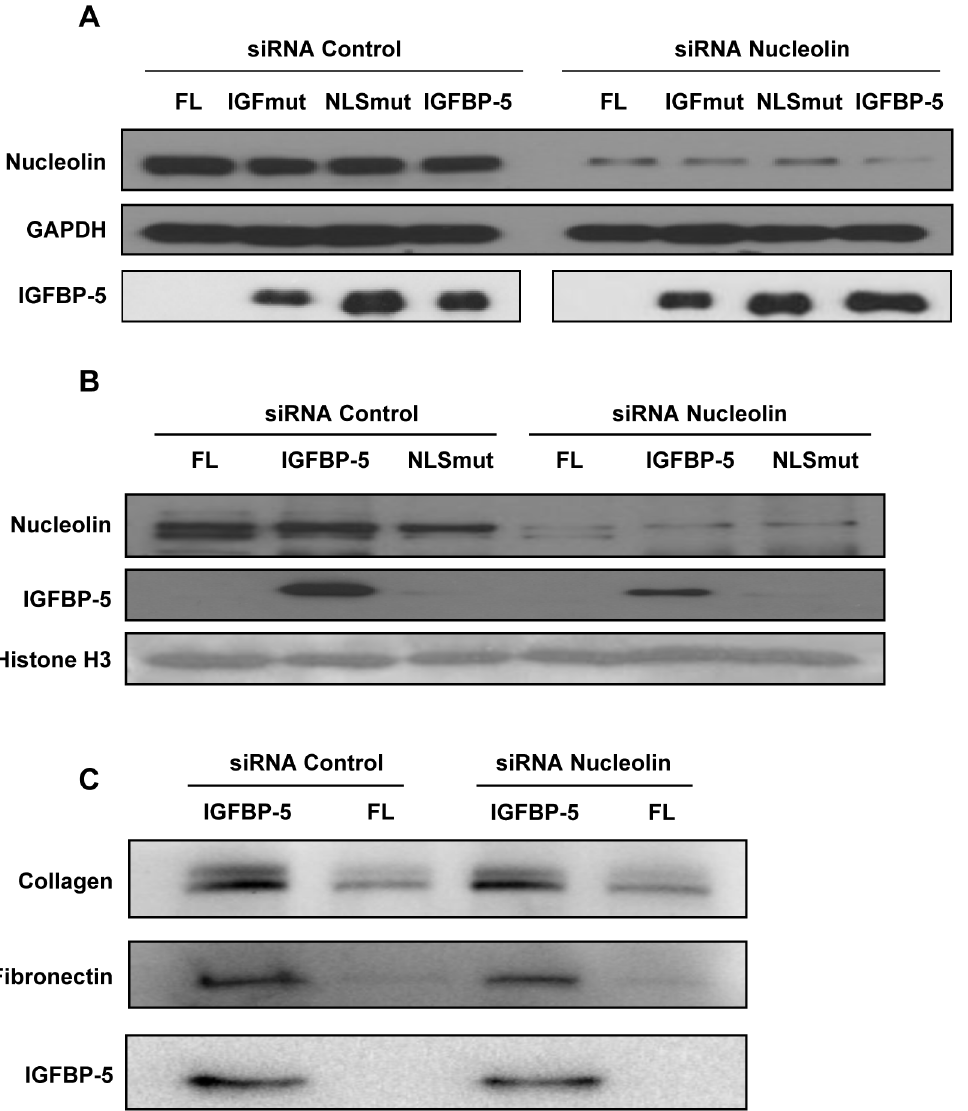
Fig 5. Silencing nucleolin does not alter the ECM-promoting effects of IGFBP-5. (A) Nucleolin is efficiently silenced using sequence-specific siRNA. Silencing nucleolin has no effect on IGFBP-5 production. (B) Silencing nucleolin inhibits translocation of IGFBP-5 to the nucleus as detected by immunoblotting of nuclear extracts. Histone H3 is used to confirm nuclear localization. (C) Silencing nucleolin does not alter the ECM-promoting effects of IGFBP-5 as detected using immunoblotting.